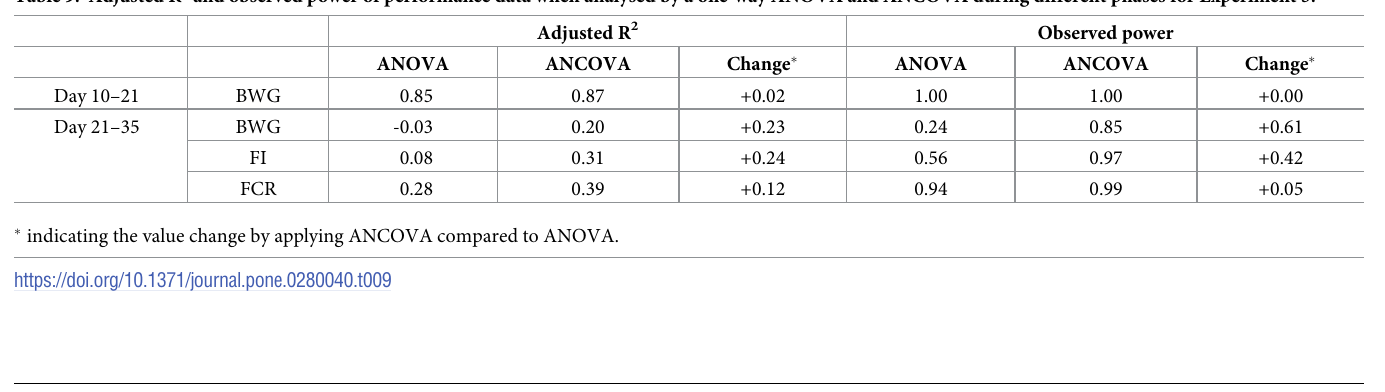
The comparative statistics for a one-way ANOVA and ANCOVA during each phase in experiment 3 are presented in Tables 8 and 9. As there was no significant correlation between male % and the dependent variables during d 0–10, ANCOVA was not performed for this period. From d 10–21 only the BWG data was analysed using male % as a covariate, which resulted in a decrease in MSE, a decrease in the F-statistic, an increase in the adjusted R 2 value and no change in observed power. The model significance was only slightly improved. From day 21–35, the MSE was reduced and the F-statistic was increased through the inclusion of male % as a covariate for all the parameters. There was also an improved model significance, model fit and observed power value for all the parameters. To demonstrate the beneficial effect of ANCOVA, we presented the results of two treatments from experiment 3 (T5 and T6), i.e., a ture of additives from Experiment 3. The FCR during d 21–35 was plotted against the male %